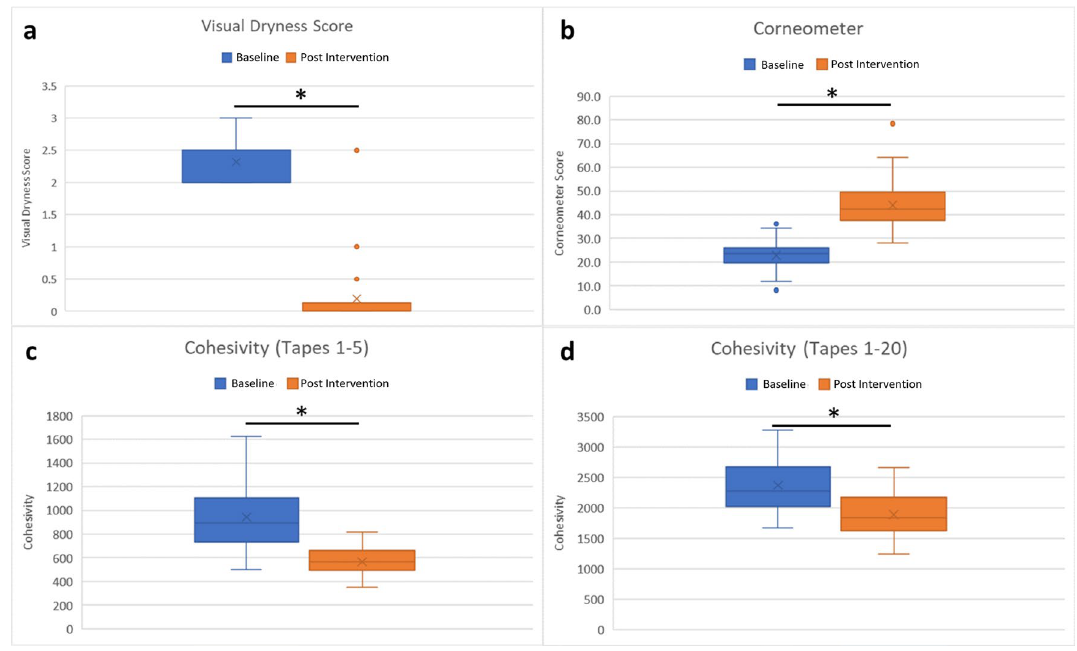
Figure 1. Lotion application improved leg skin hydration and cohesivity. Skin hydration was assessed at baseline and after 5 weeks of lotion application (n = 37) via ( a ) visual dryness and ( b ) corneometer. Stratum corneum cohesivity was assessed by protein removal on ( c ) 5 sequential tape strips and ( d ) 20 sequential tape strips (n = 36). Box whisker plots showing mean and upper and lower quartiles. Connecting line with an asterisk indicates a statistically significant